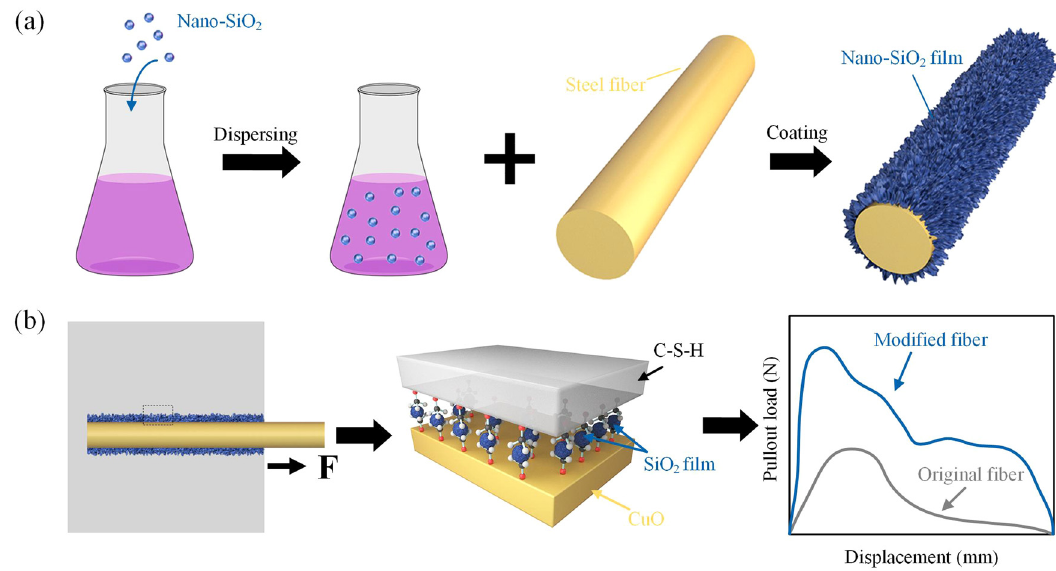
Figure 4: ( a ) Schematic diagram of the nano - SiO 2 coating process on a steel fi ber surface. ( b ) Pullout behavior of steel fi ber with nano - SiO 2 fi lm from SFRCC matrix. The C – S – H binds tightly to CuO through the coated nano - SiO pullout